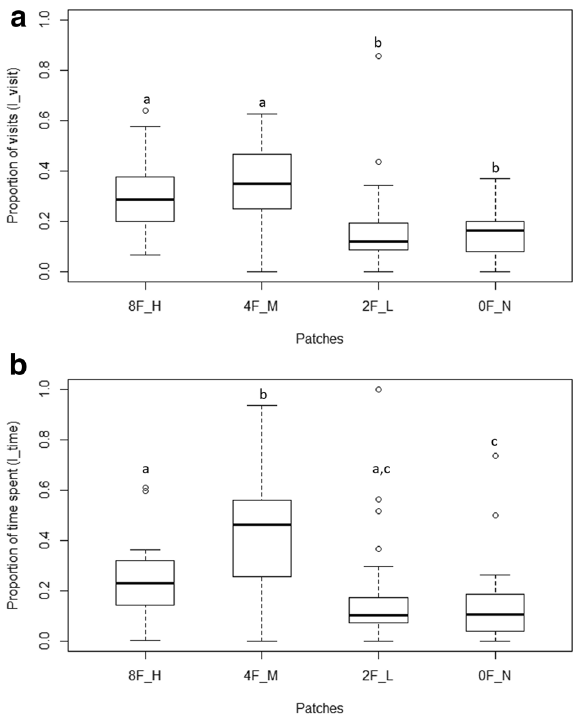
Figure 4. ( a ) Boxplots showing the proportion of visits (I_visit) by the male to the various chambers containing the females in varying density in vegetation presence (E1 set). High (H) and medium (M) chambers having eight females (and high plant density) and four females (and medium plant density) respectively had a higher proportion of visits by the male compared to the low (L) (two females and low plant density) and null (N) (one female and no plants) chambers. Similar alphabets placed above the plots indicate no statistical difference whereas dissimilar alphabets indicate significant statistical difference (p < 0.05). The lower and upper ends of the box plots represent the 1st and 3rd quartiles, the horizontal line within each boxplot is the median, and the upper and lower whiskers are the ×1.5 the interquartile range. Outlines are shown as open circles. ( b ) Boxplots showing the proportion of time (I_time) spent by the male in each of the chamber (E1 set). Males spent a significantly greater proportion of time in medium (M) chamber compared to the other three patches. Similar alphabets placed above the plots indicate no statistical difference whereas dissimilar alphabets indicate significant statistical difference (p < 0.05). The lower and upper ends of the box plots represent the 1st and 3rd quartiles, the horizontal line within each boxplot is the median, and the upper and lower whiskers are the ×1.5 the interquartile range. Outlines are shown as open